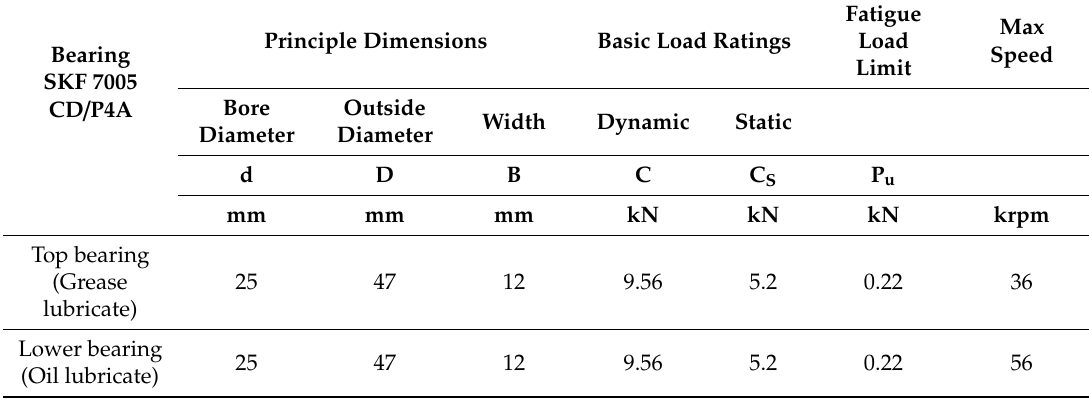
Table A5. Angular contact super precision ball bearing specifications